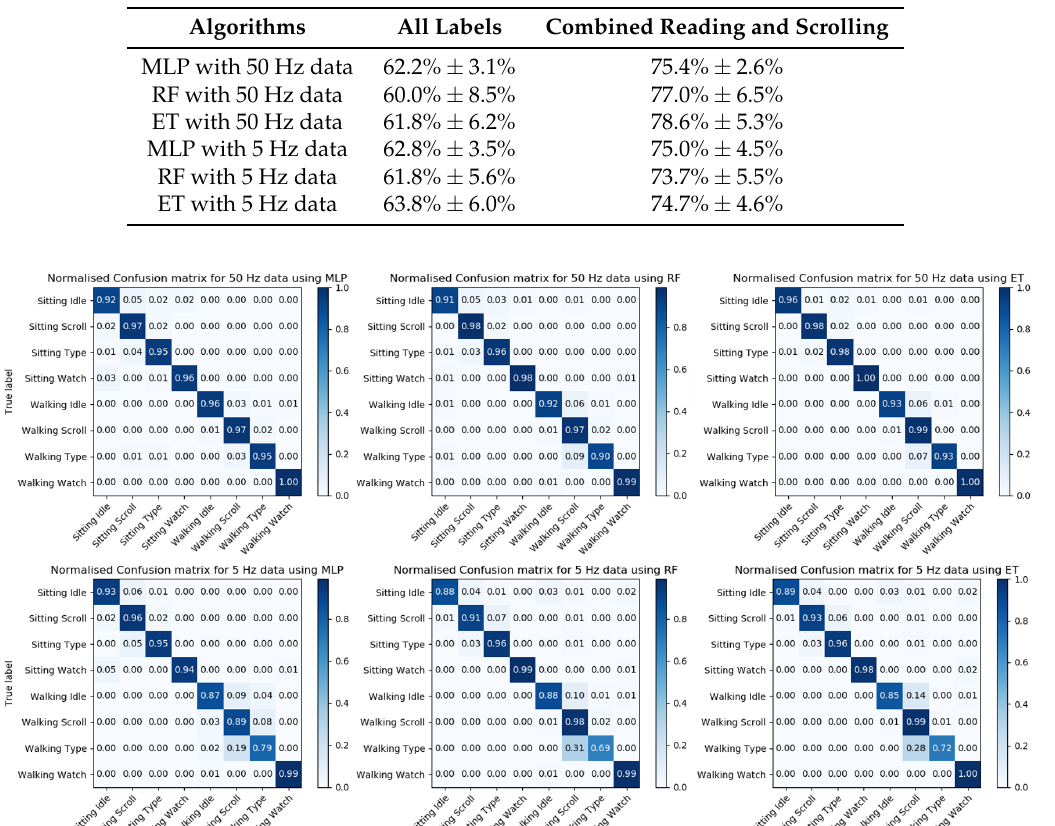
Table 5. Cross-validation score for the three models (MLP, RF and ET) with different frequencies.